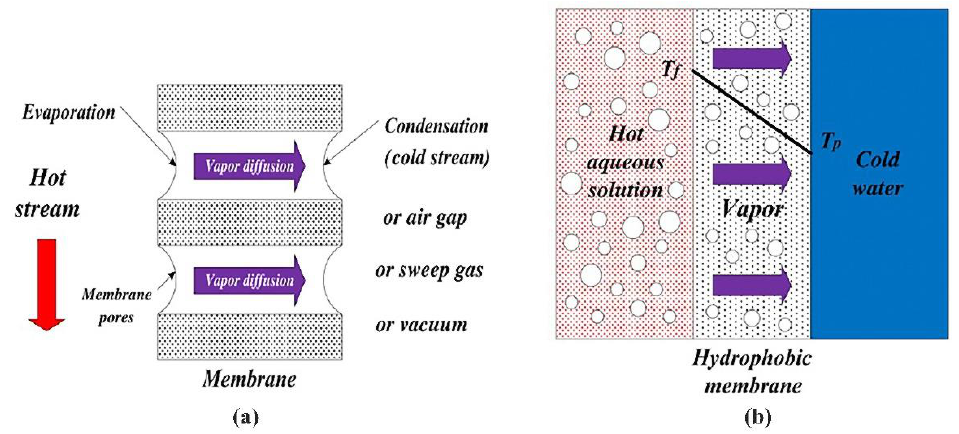
Figure 3. The working principles of an MD unit: ( a ) diffusion of vapors and prevention of passage of liquids through the membrane due to its hydrophobic properties; and ( b ) transfer of water vapor from the hot stream to the cold stream due to a partial pressure difference created by the temperature difference between different sides of the membrane. Reproduced with permission from [111]. Copyright © 2016,